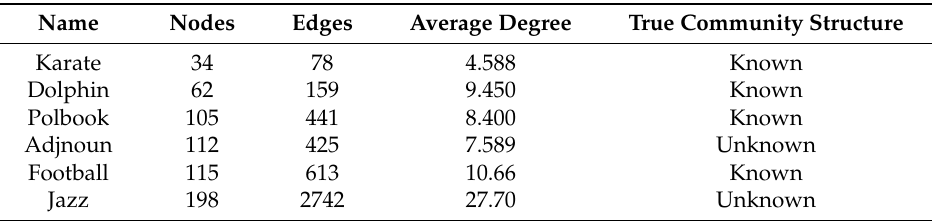
Table 1. Six detected real-world